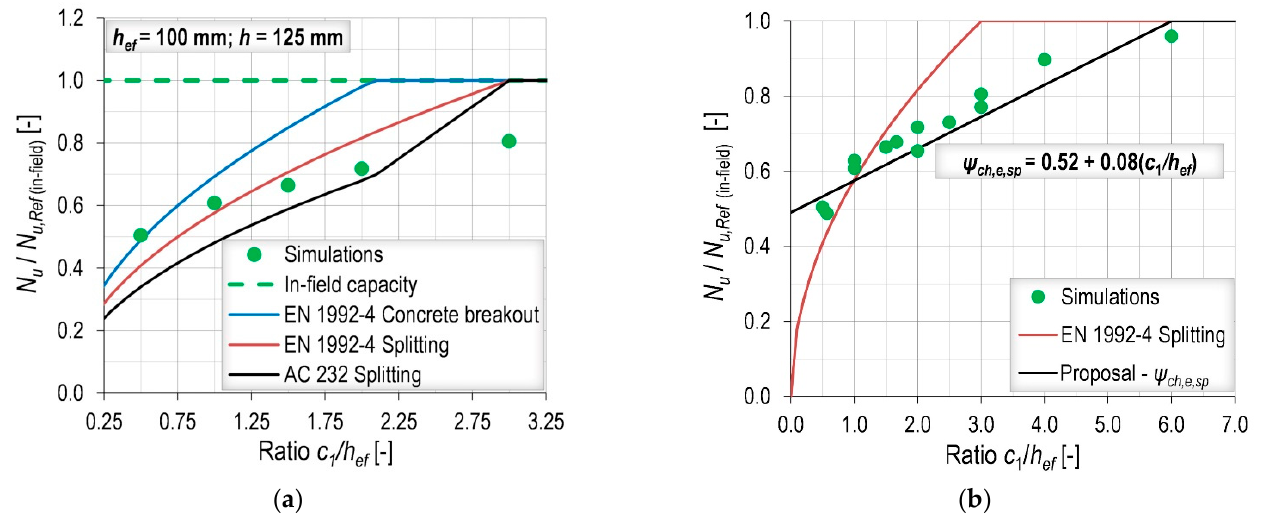
Figure 7. Influence of edge distance: ( a ) numerical results compared to the current code provisions; ( b ) numerical results for different embedment depths and small h/hef ratios described by a linear function.